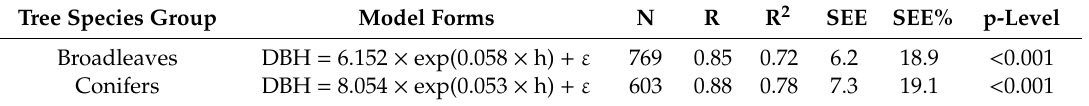
Table 2. Regression models for diameters to breast height (DBH)